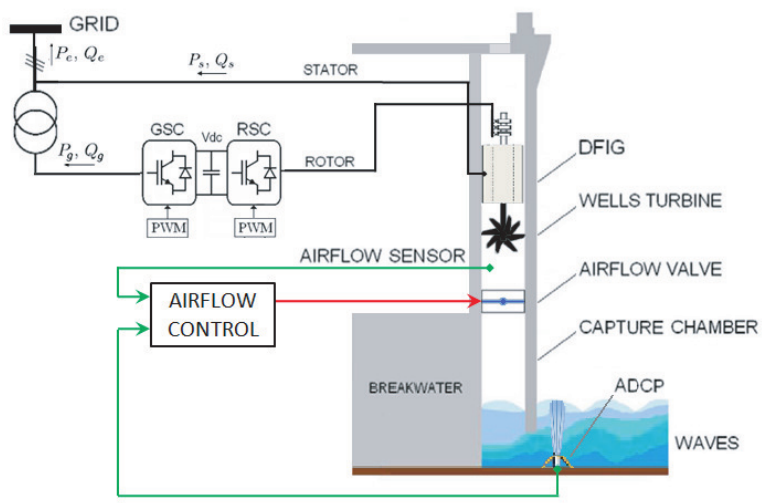
Figure 7. Airflow control scheme for a Wells turbine-based OWC wave power plant.